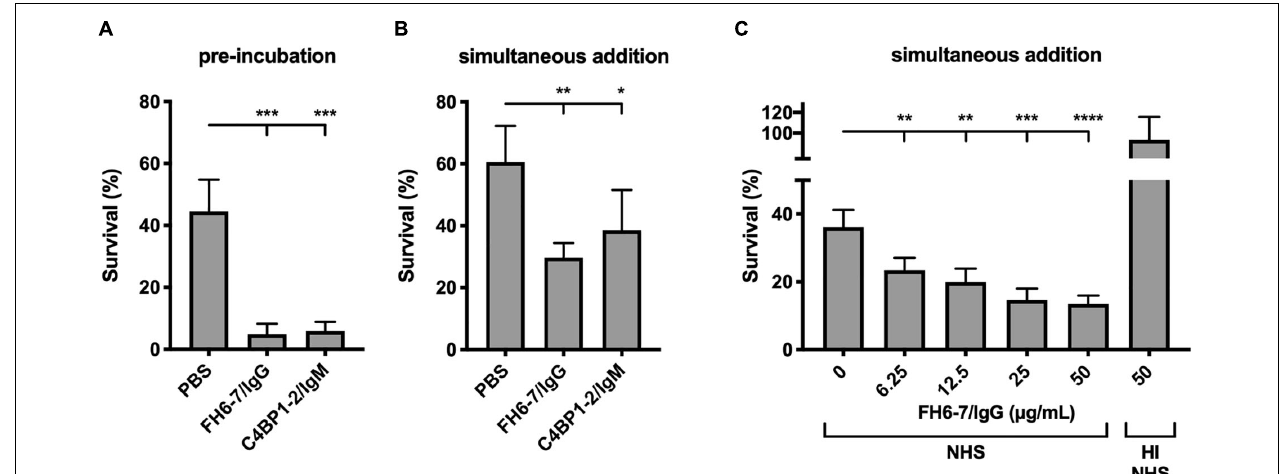
FIGURE 4 | FH6-7/IgG and C4BP1-2/IgM increase serum killing of M. catarrhalis . (A) Bacteria were pre-incubated with PBS (control), 50 µ g/ml of FH6-7/IgG or 50 µ g/ml of C4BP1-2/IgM for 30 min before addition of 10% NHS. Bacteria were counted at t = 0 and t = 30 min post-addition of serum and survival percentage was calculated. (B) Fusion proteins and serum were added simultaneously to the bacteria, and bacteria survival was calculated. (C) Increasing amounts of FH6-7/IgG were added simultaneously with NHS to bacteria and survival was calculated. Heat-inactivated NHS was used as a negative control of bacteria killing. Mean ( ± SD) from three (A,C) or four (B) independent experiments are shown. Statistical significance of differences was calculated using one-way ANOVA with Dunnett’s post-test; * p < 0.05; ** p < 0.01; *** p < 0.001; and **** p <